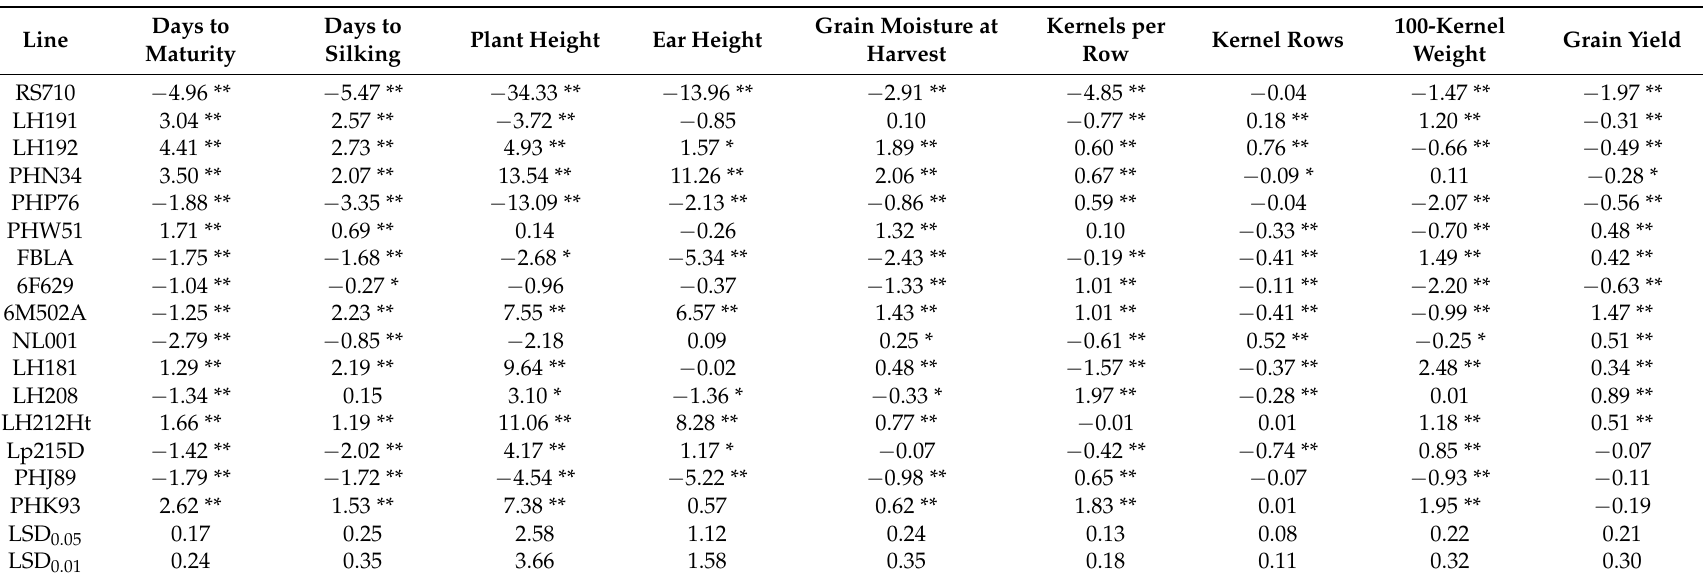
Table 10. The general combining ability of USA inbred lines for machine-harvest and yield